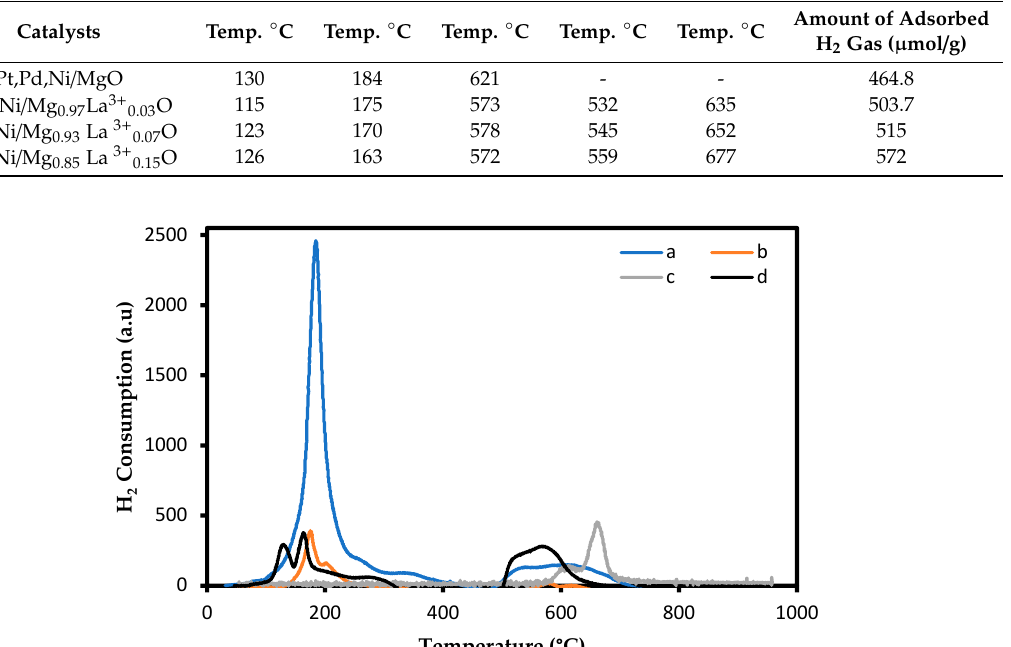
Figure 4. H 2 -TPR profiles of the catalysts ( a ) Pt,Pd,Ni / MgO, ( b ) Pd,Pd,Ni / Mg 0.97 La 3 + 0.03 O, ( c ) Pd,Pd,Ni / Mg 0.93 La 3 + 0.07 O, and ( d ) Pd,Pd,Ni / Mg 0.85 La 3 + 0.15 O reduced in a (5% H 2 / Ar) stream at a temperature ramp of 10 ◦ C / Table 2. H 2 -TPR values of the different catalysts.